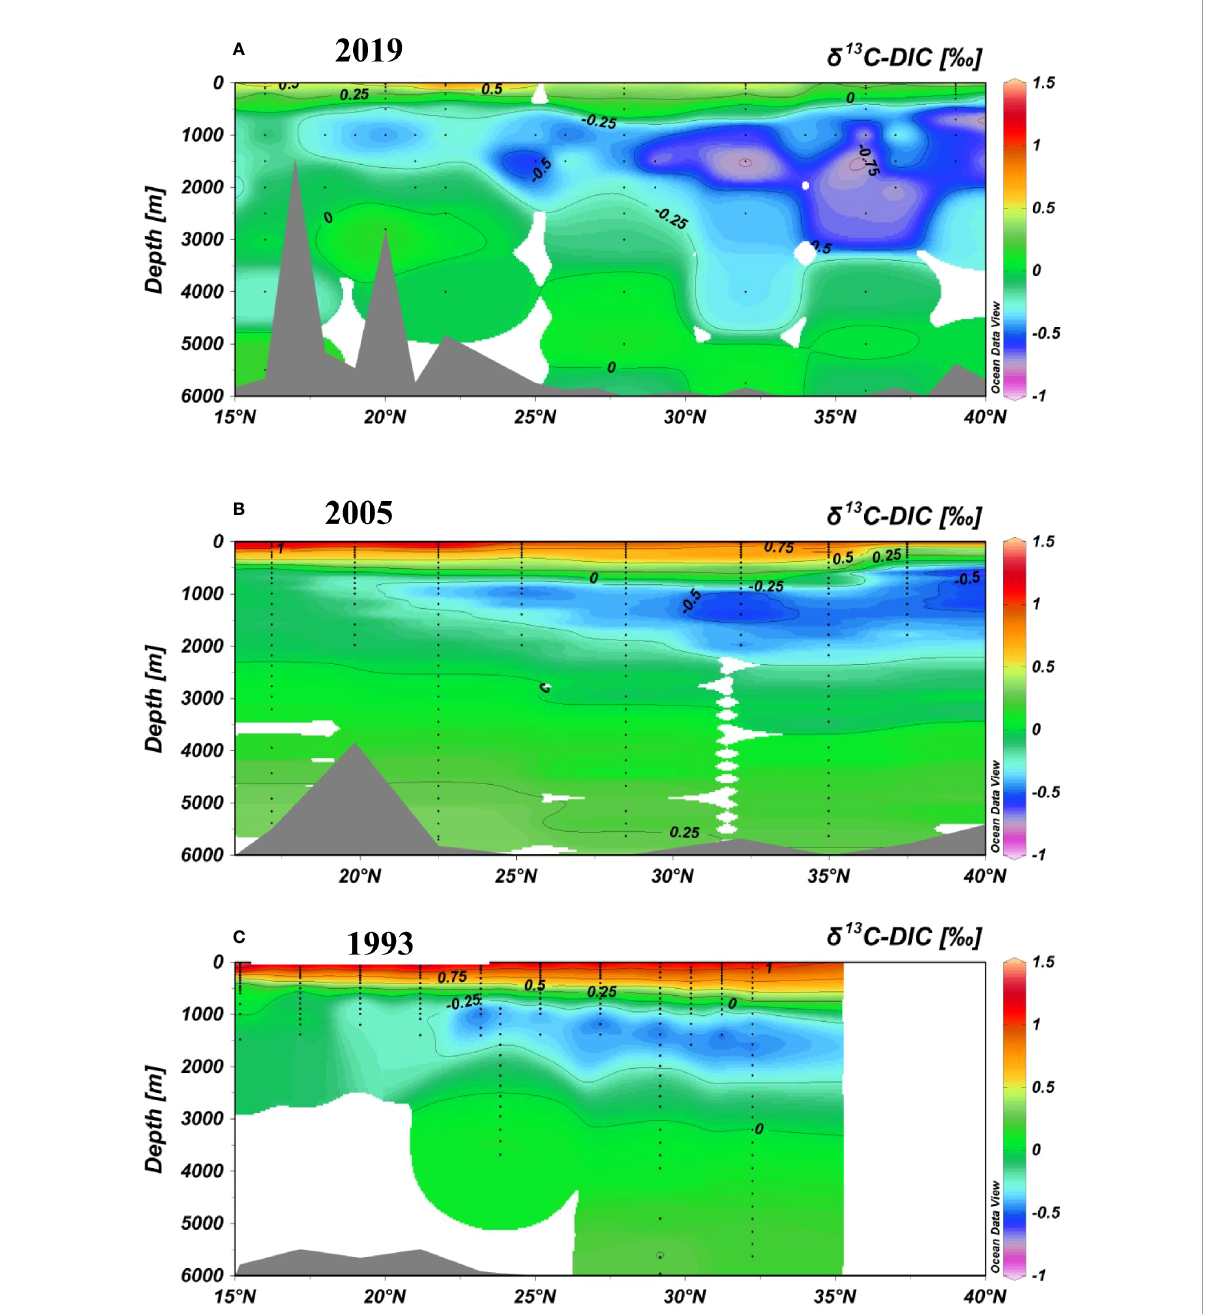
FIGURE 6 Latitudinal distributions of the d 13 C-DIC values measured for (A) transect P1 in 2019 in our study; (B) CLIVAR line P10N in 2005; and (C) WOCE line P10 in 1993 in the northwestern NP using ODV. The data for lines P10N and P10 were obtained from the GLODAP database (https://www.